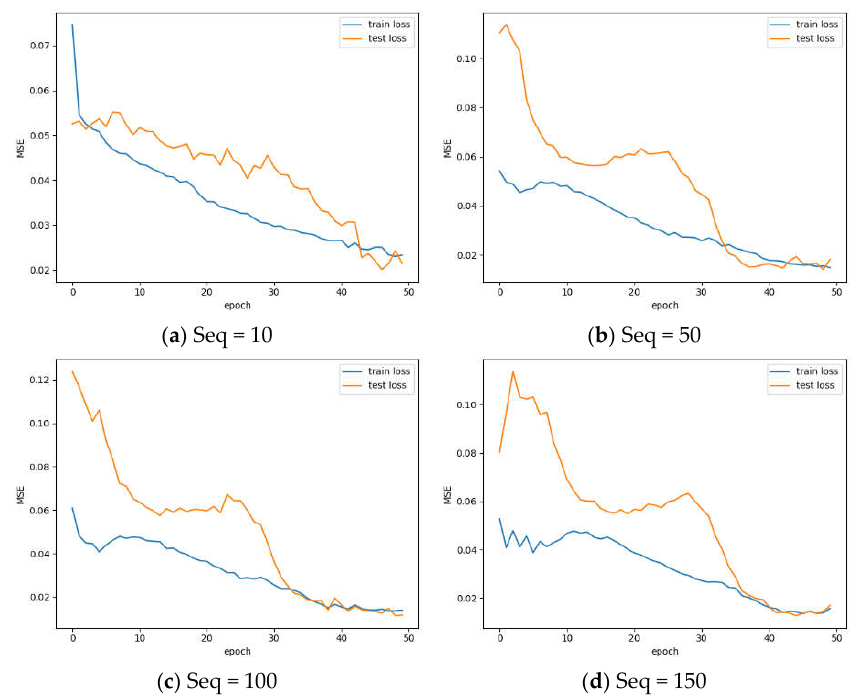
Figure 2. Parameter batch_size adjustment experiment. We set batch_size to 16, 32, 64, and 80 for comparative experiments.